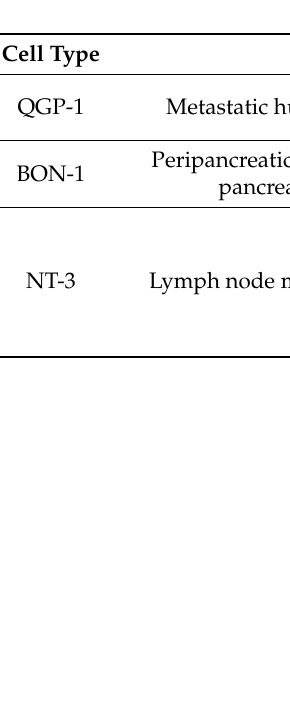
Table 11. In vitro models: cell